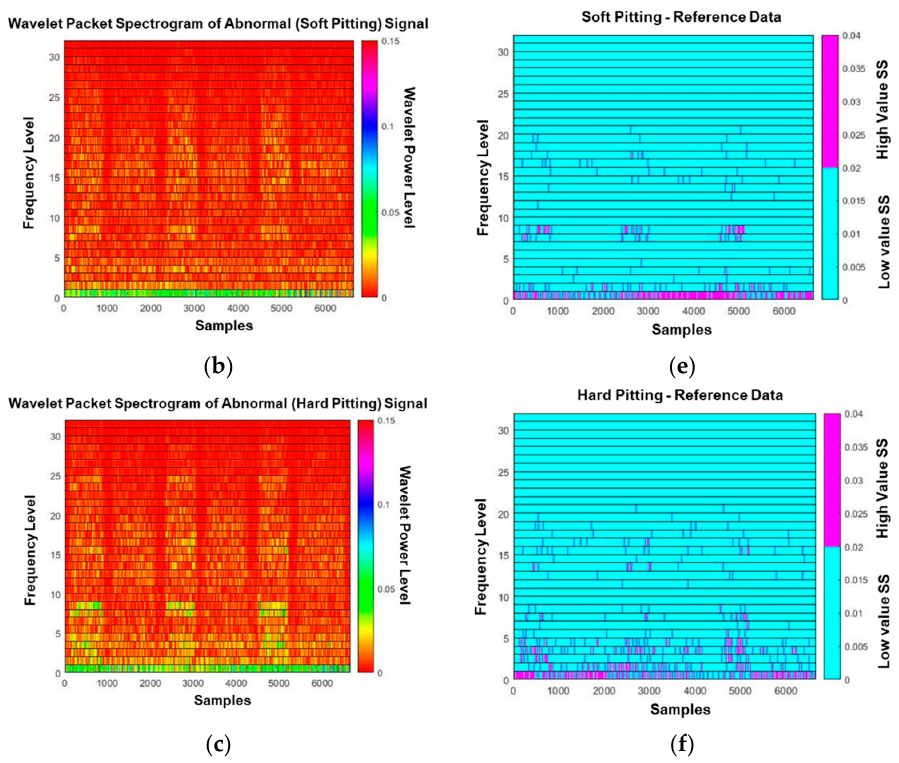
Figure 10. Wavelet packet spectrograms of ( a ) a normal signal, ( b ) an abnormal (soft-pitting) signal, and ( c ) another abnormal (hard-pitting) signal; ( d ) N-R spectrogram, ( e ) A-R (S-R) spectrogram, ( f ) A-R (H-R) spectrogram.